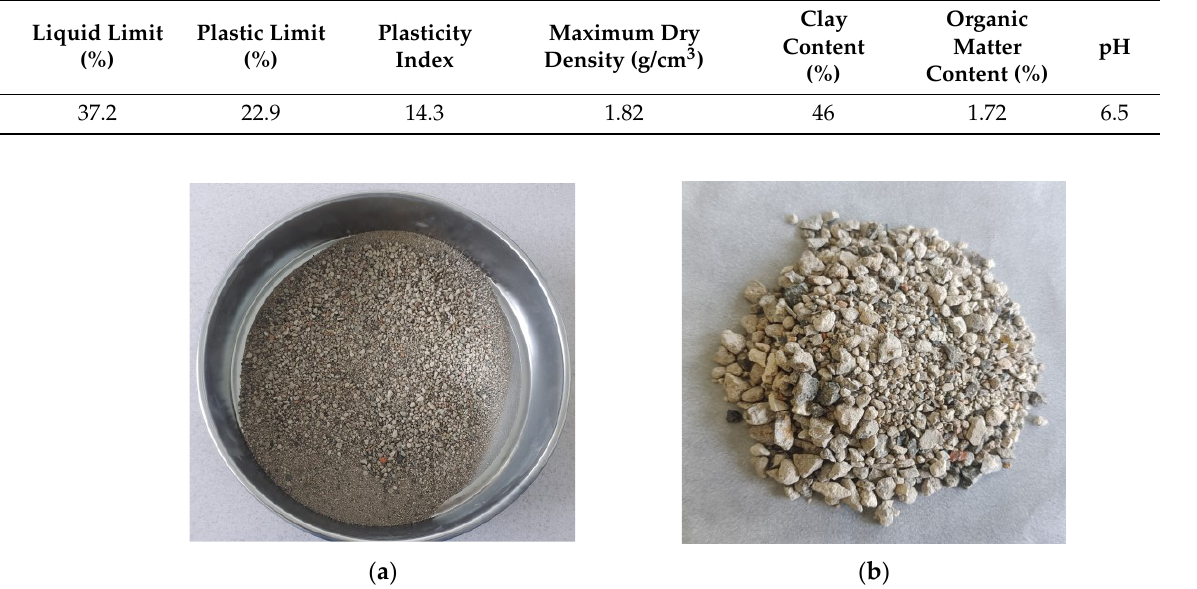
Figure 1. Recycled fine aggregate. ( a ) Original recycled fine aggregate; ( b ) Recycled fine aggregate after screening. Table 1. Physical properties of recycled fine